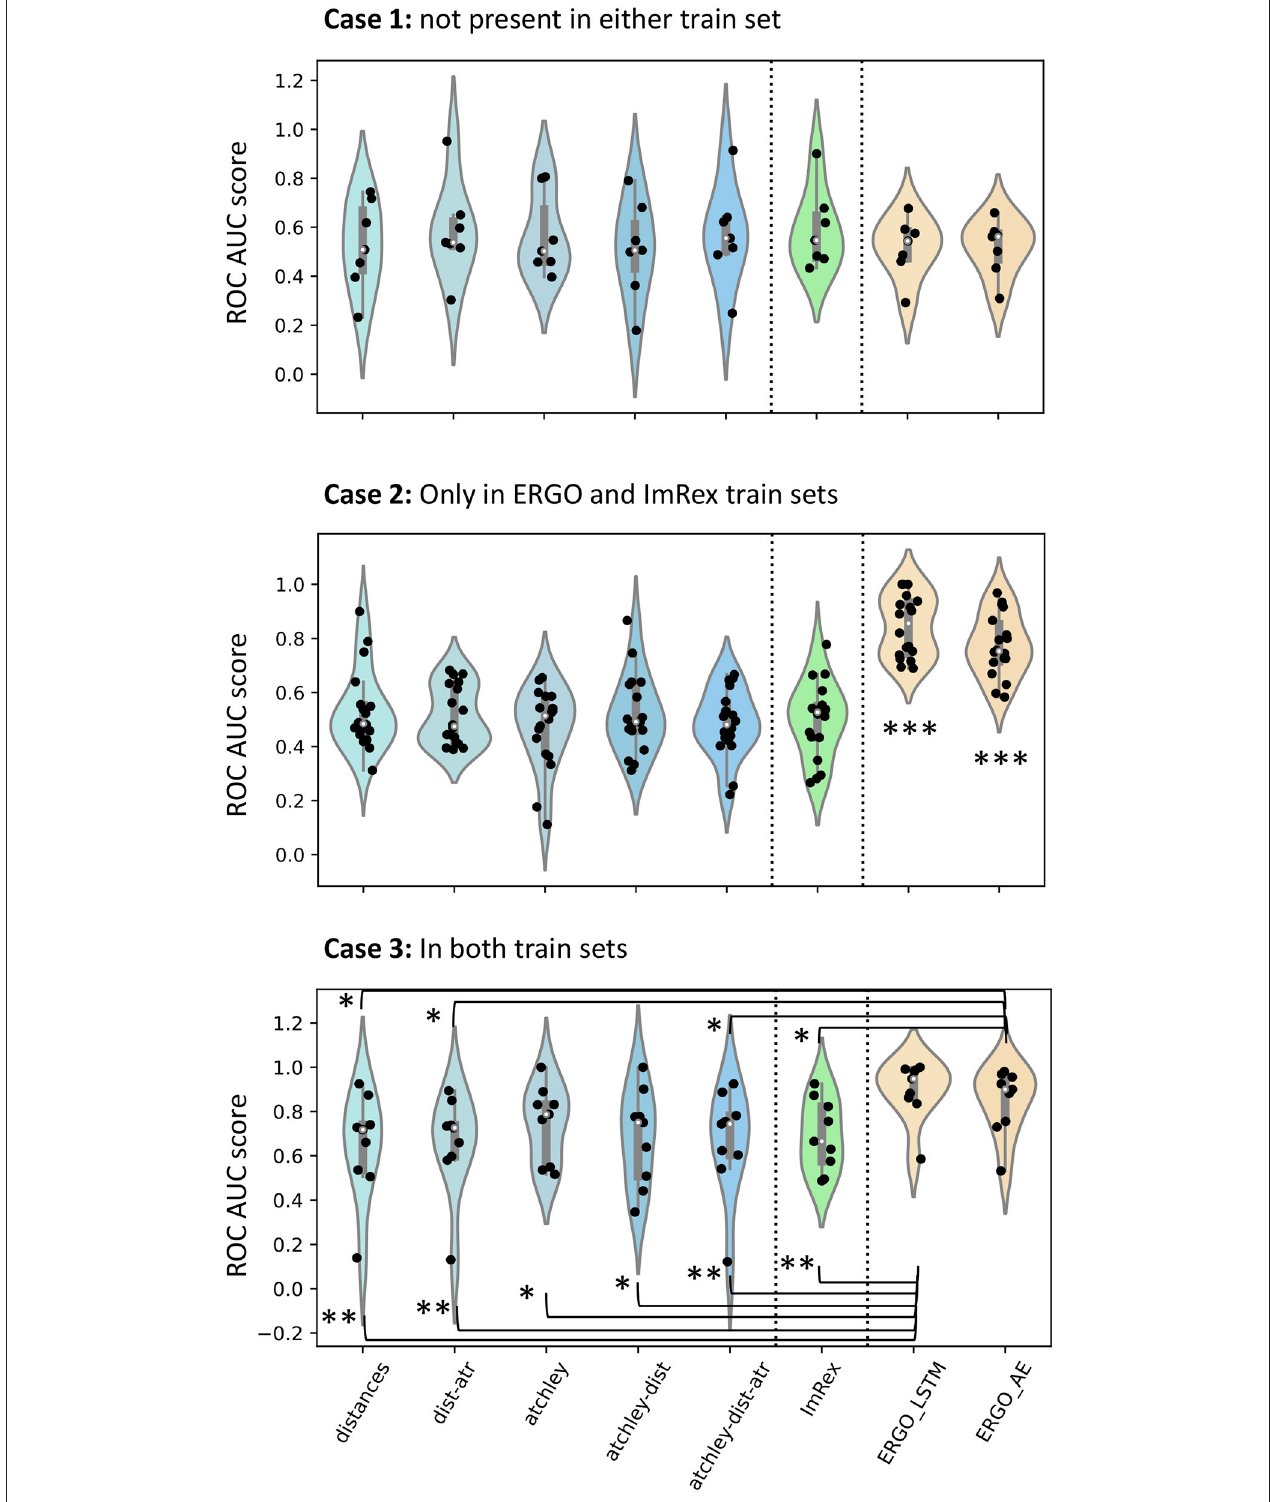
FIGURE 9 | Comparison of performance with other published tools. In each violin plot, a dot is an epitope for which performance is calculated. In Case 1, only epitopes that are not present in the PDB or in the VDJDb train sets are included. In Case 2, only epitopes that are present in the VDJDb but not in the PDB are included. In Case 3, only epitopes which are in both training sets are included. To look for differences, a Mann-Whitney U -test was calculated and significance values are shown: * p < 0.05; ** p < 0.01; *** p < 0.001.